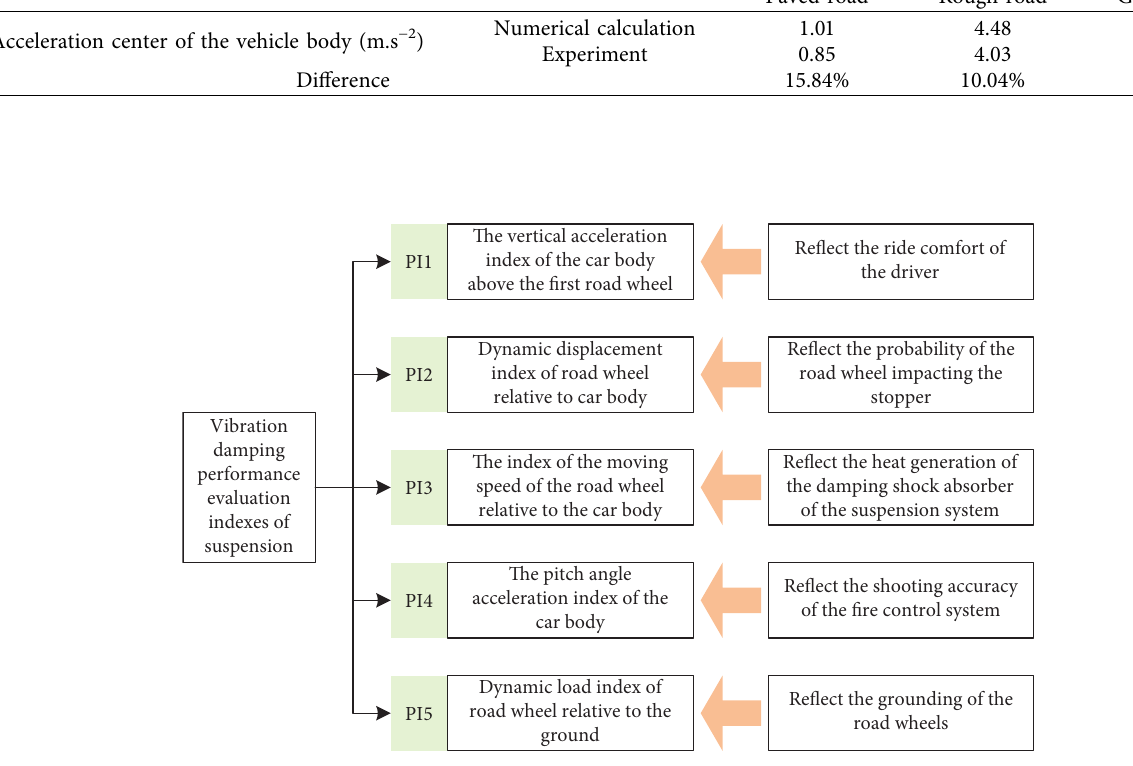
Road Paved road Rough road Gravel road